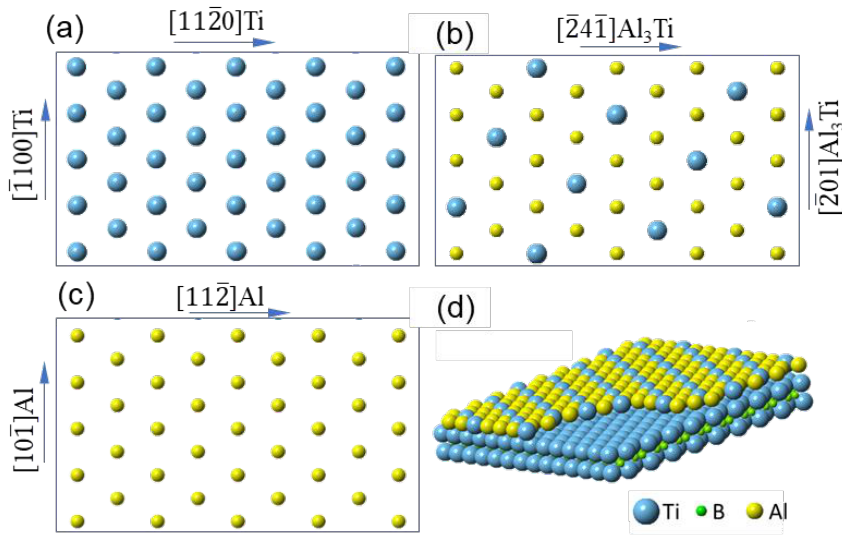
Figure 7. Atomic arrangement of the matching planes at the interface between Al, Al 3 Ti 2DC and TiB 2 [11]. Schematics showing ( a ) Ti atoms in (0 0 0 1)TiB 2 plane; ( b ) Ti and Al atoms in (1 1 2)Al 3 Ti plane; ( c ) Al atoms in (1 1 1)Al plane; and ( d ) 3D illustration of Al 3 Ti 2DC on the TiB 2 surface.